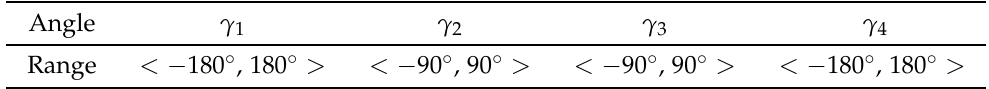
Table 2. Angle range per joint for the inverse kinematics